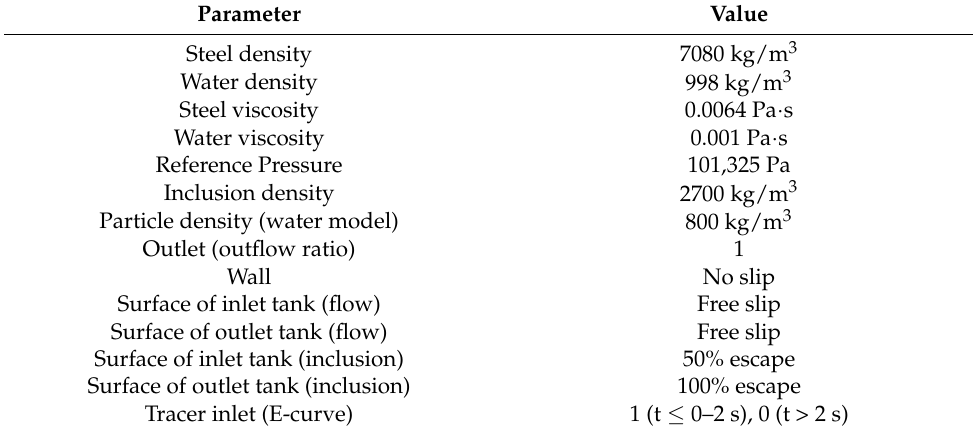
Table 3. Input parameters and boundary conditions used for computational fluid dynamics (CFD) simulations and water